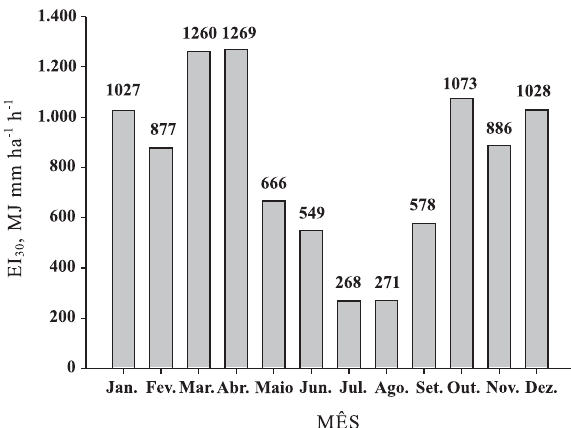
Figura 1. Erosividade média mensal das chuvas de São Borja, RS, no período de 1956 a 2003, determinada pelo índice EI 30